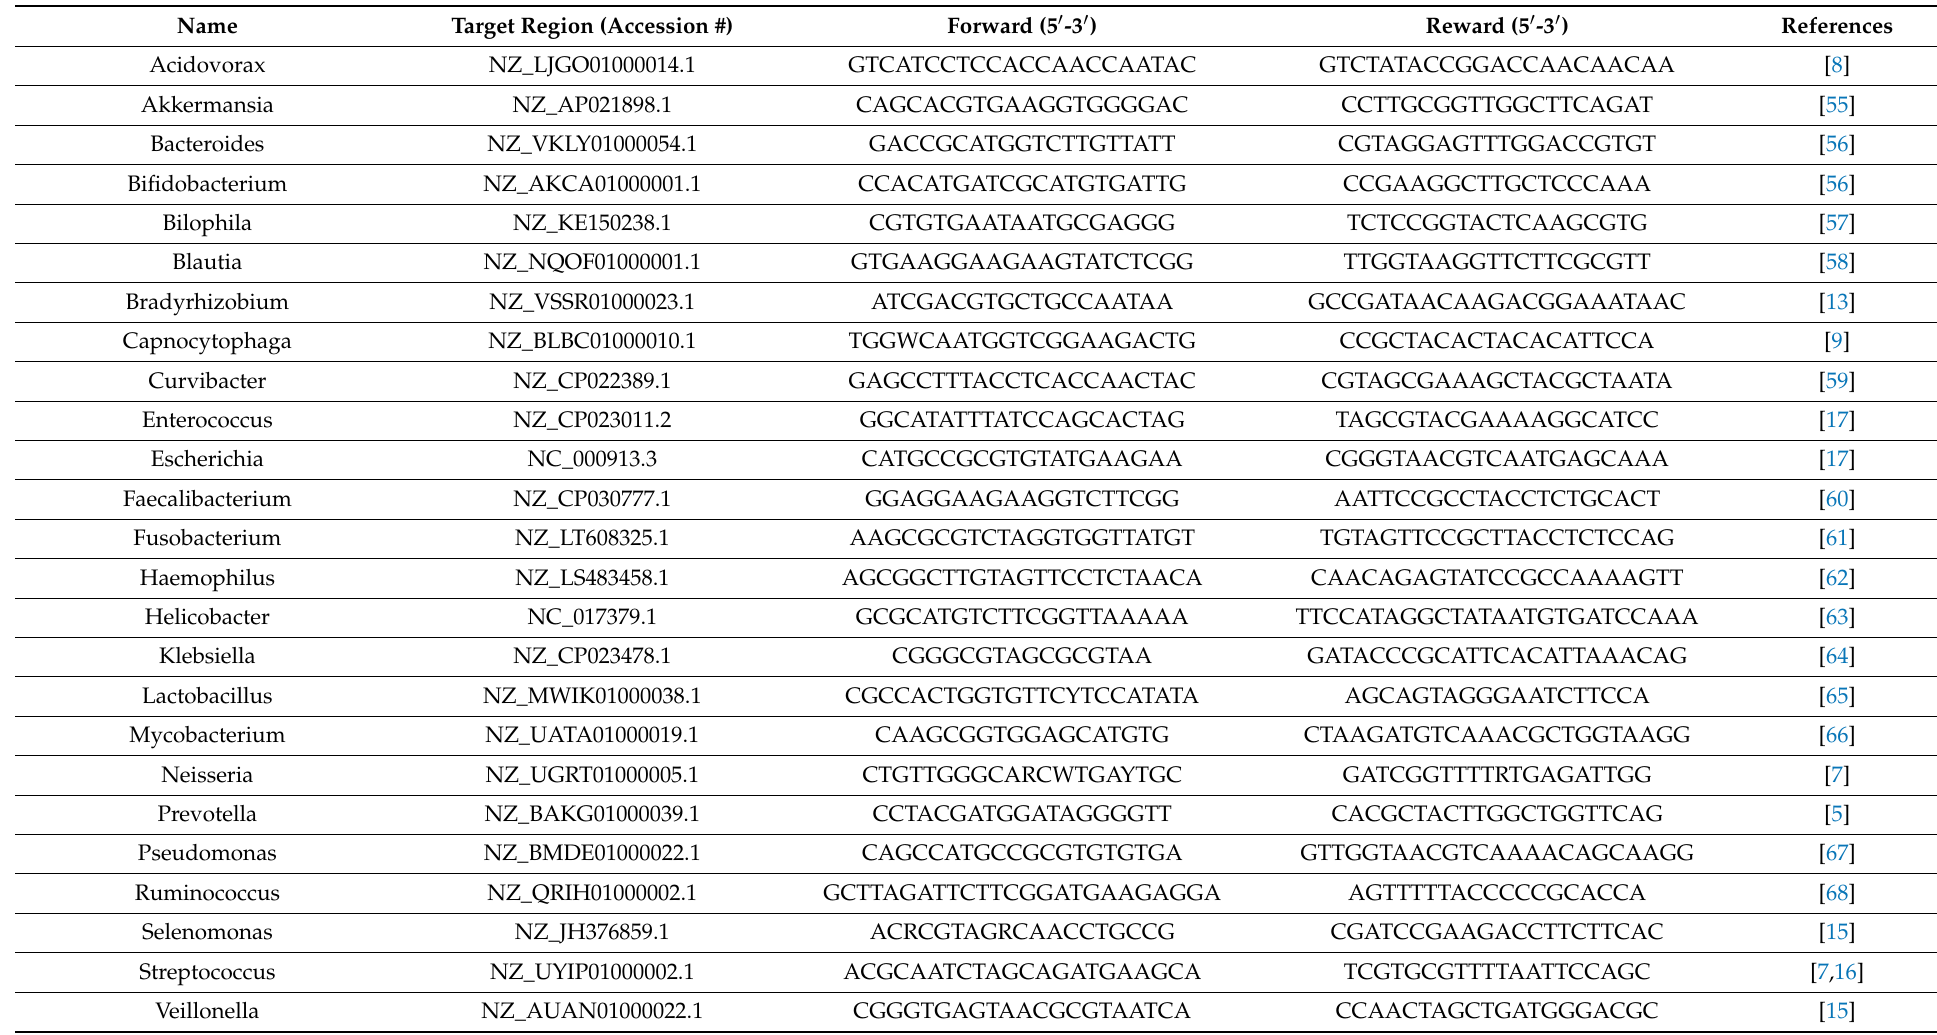
Table 3. Twenty-five bacterial genera tested by ddPCR and their